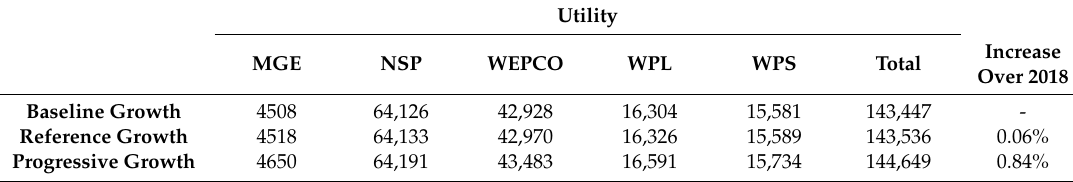
Table 3. Modeled 2030 annual load (GWh / year) in Wisconsin utilities resulting from the baseline, reference, and high-adoption growth scenarios. Energy increase over baseline scenario are shown.